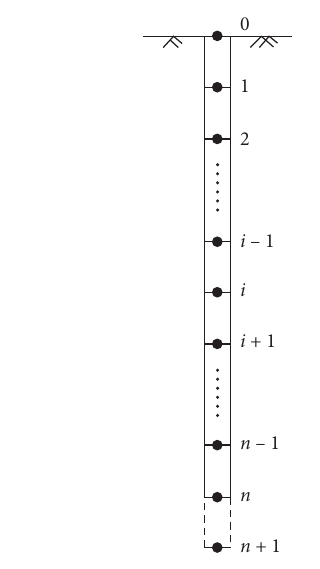
Figure 2: Diagrammatic sketch of differential dispersion of ver- tically loaded